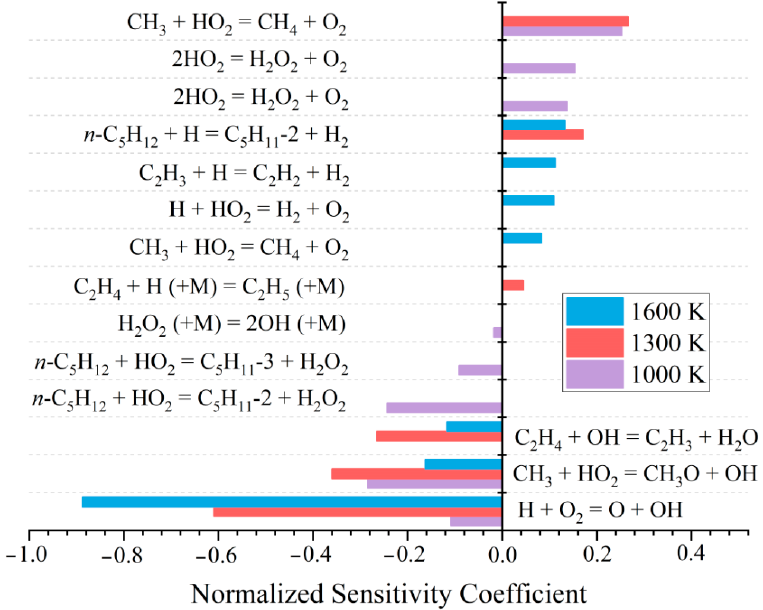
Figure 1. The normalized sensitivity coefficients of ignition delay time calculated with NUIG at an equivalent ratio of 1.0 and temperatures of 1000 K, 1300 K and 1600 K, respectively.